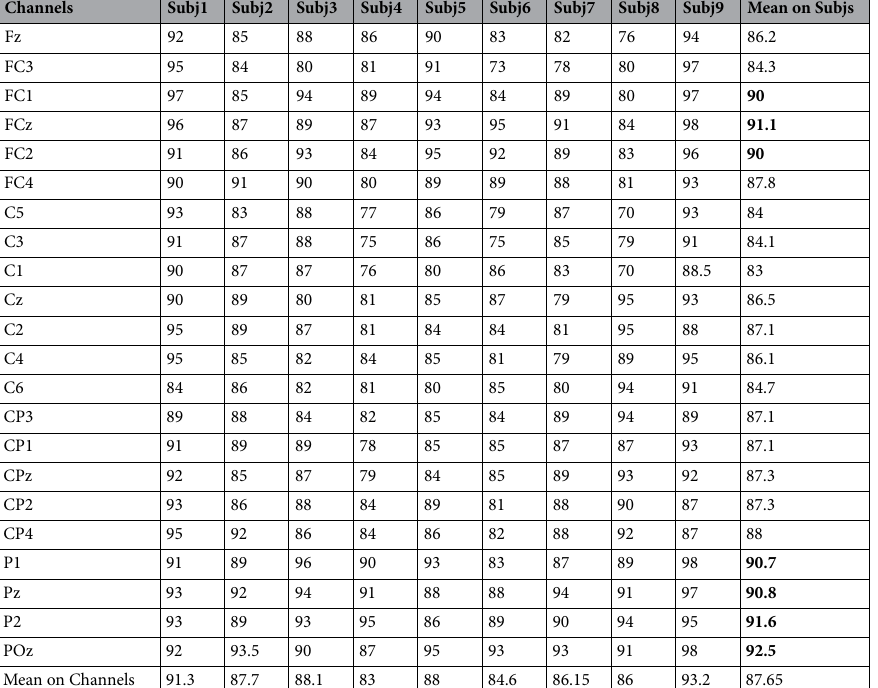
Table 2. Accuracy of customized EEG-CLFCNet (CD) on each electrode for 9 subjects on BCI Competition IV dataset 2a. Significant values are in [bold].